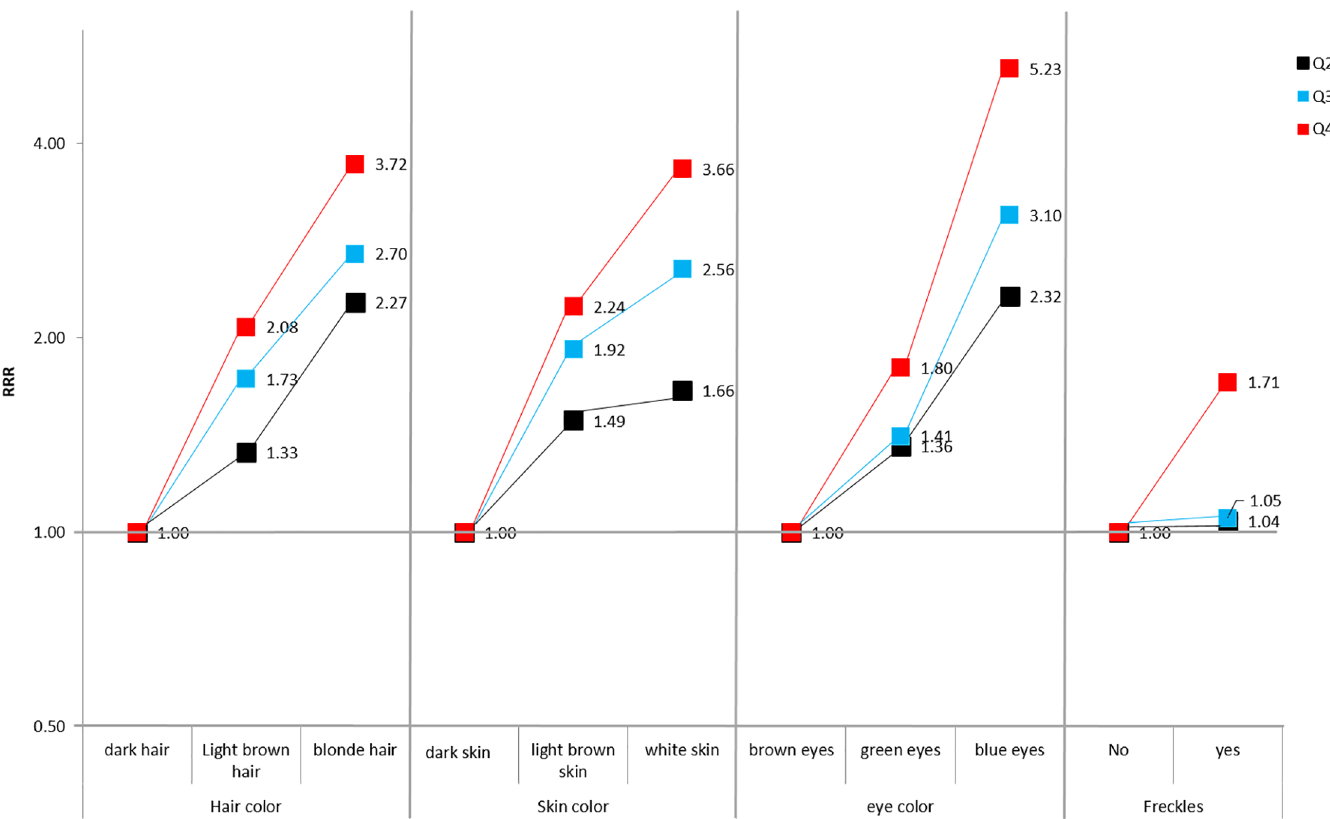
Fig 1. Relationship in controls, between phototype pigmentation and the genetic pigmentation score of the phototype in quartiles. Relative Risk Ratio (RRR).